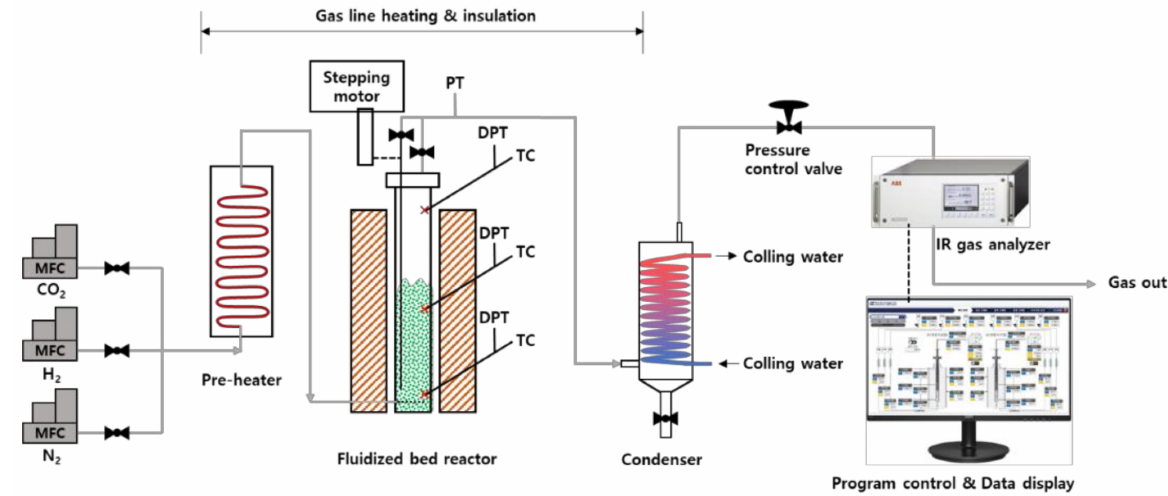
Figure 9. Schematic diagram of fluidized bed reactor for CO 2